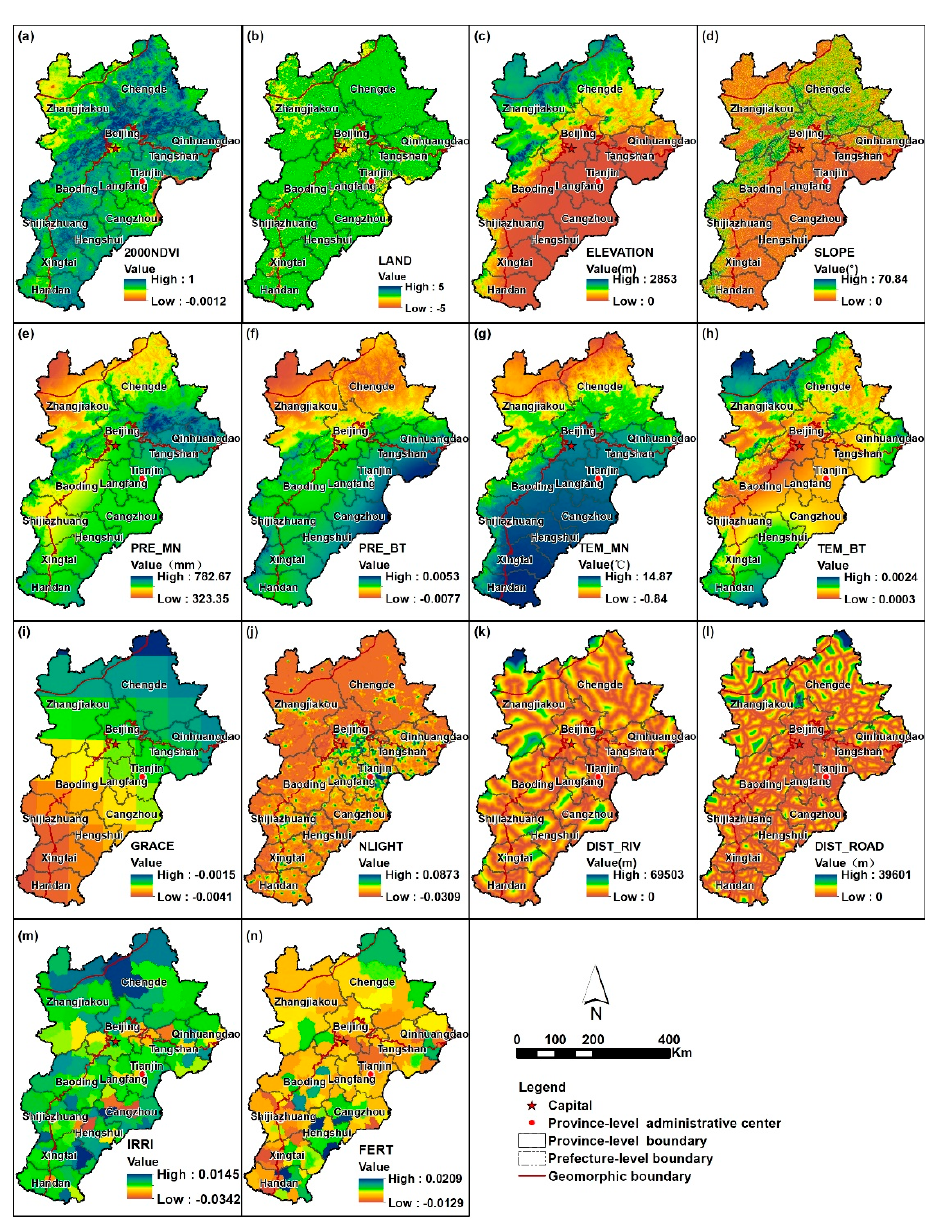
Figure A1. Fourteen explanatory variable distribution maps. ( a ) initial NDVI. ( b ) Land cover type Appendix 2. Fourteen explanatory variable distribution maps. (a) initial NDVI. (b) Land cover type change. ( c ) Elevation. ( d ) Slope. ( e ) Annual average precipitation. ( f ) Changes in precipitation during change. (c) Elevation. (d) Slope. (e) Annual average precipitation. (f) Changes in precipitation during the growing season. ( g ) Annual average temperature. ( h ) Changes in temperature during the growing the growing season. (g) Annual average temperature. (h) Changes in temperature during the growing season. ( i ) GRACE changes. ( j ) NLIGHT changes. ( k ) River Euclidean distance. ( l ) Road Euclidean season. (i) GRACE changes. (j) NLIGHT changes. (k) River Euclidean distance. (l) Road Euclidean distance. ( m ) Irrigation change ( n ) and fertilization distance. (m) Irrigation change (n) and fertilization change.